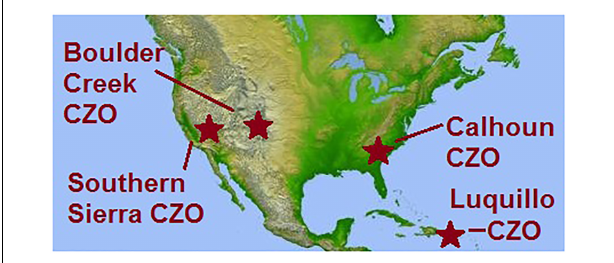
FIGURE 1 | Map of Boulder Creek, Calhoun, Luquillo, and Southern Sierra CZOs investigated in this